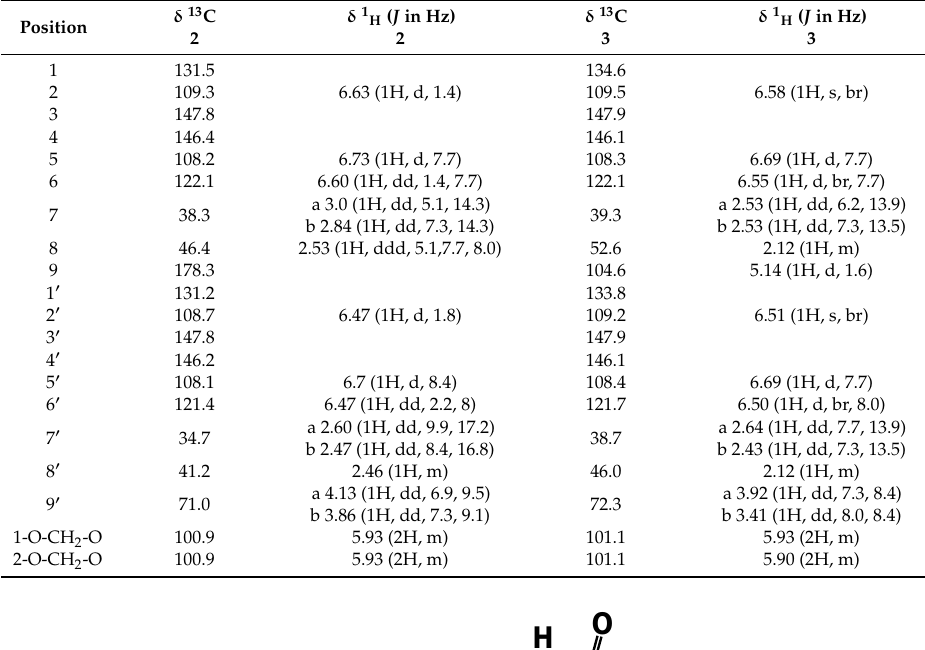
Table 1. NMR spectroscopy data ( 1 H and 13 C, in CDCl 3 ) of compounds 2 and 3.